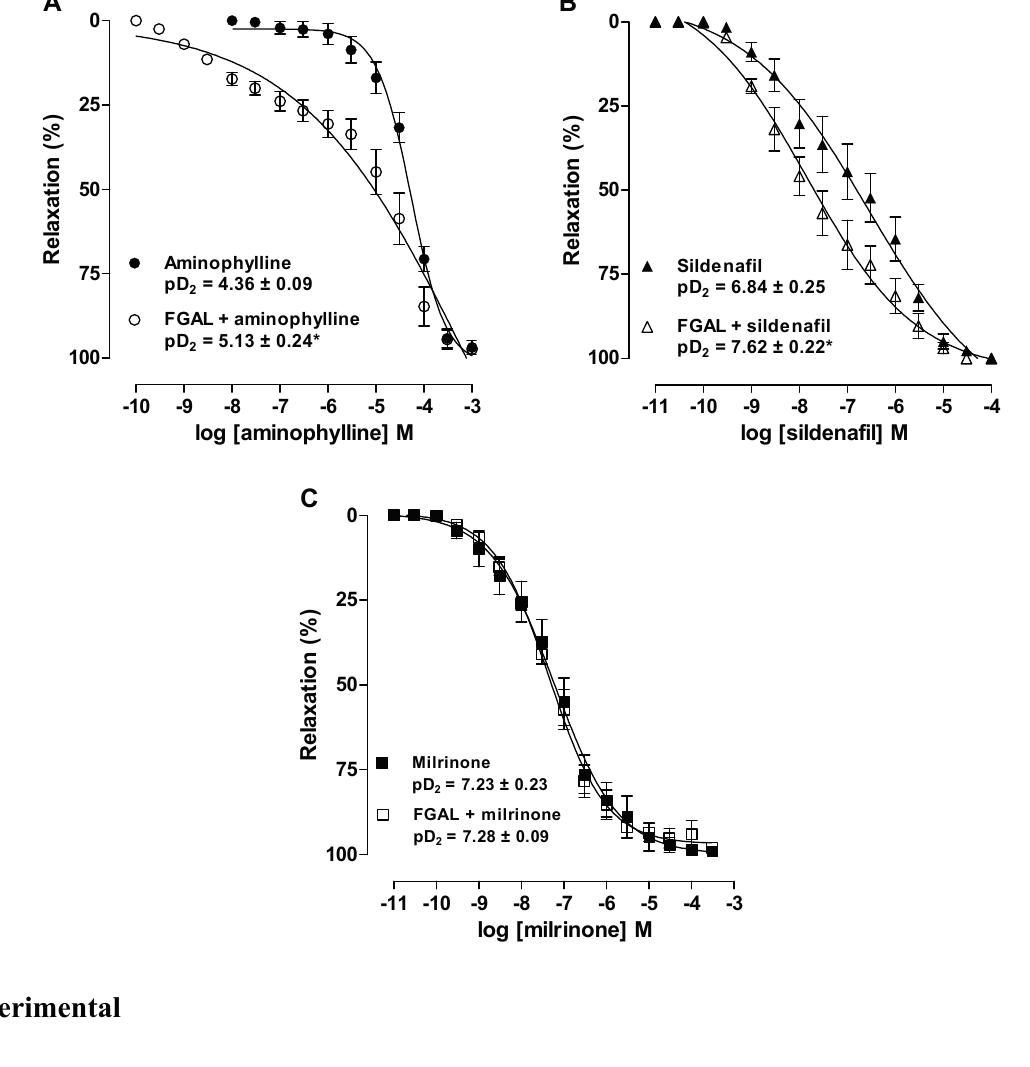
Figure 9. Effect of aminophylline ( A , ● ) sildenafil ( B , ▲ ) and milrinone ( C , ■ ) on tonic contractions induced by 3 × 10 − 7 M Phe in both the absence and presence of 3 × 10 − 6 M FGAL ( ○ , ∆ and □ , respectively). Symbols and vertical bars represent the mean and S.E.M., respectively. Student’s t -test, * p < 0.05 (aminophylline/sildenafil vs. FGAL + aminophylline/sildenafil), n =